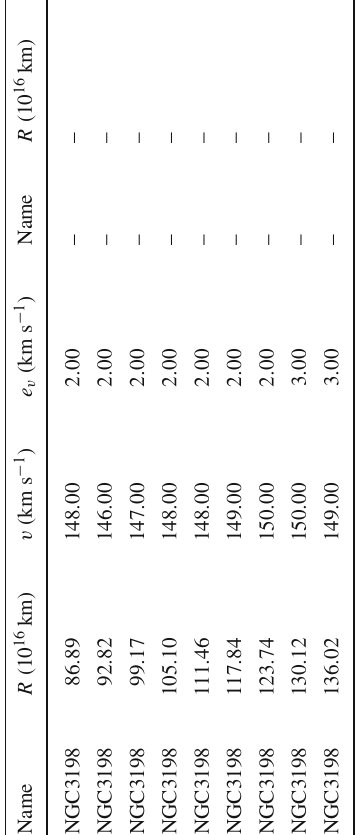
value, we fit the unknown coupling parameter α . Besides the effectonthevalueofthisconstant,thevariousvaluesof n also had an effect on the units of the constant. In the grid figures of Fig. 2, we show plots of all the regions under consideration. The index regions of negative n , n = 0, and 0 < n < 1 are discarded due to their velocity profile never vanishing for very large radii. Moreover, the intermediate region behaves very poorly in several instances of those